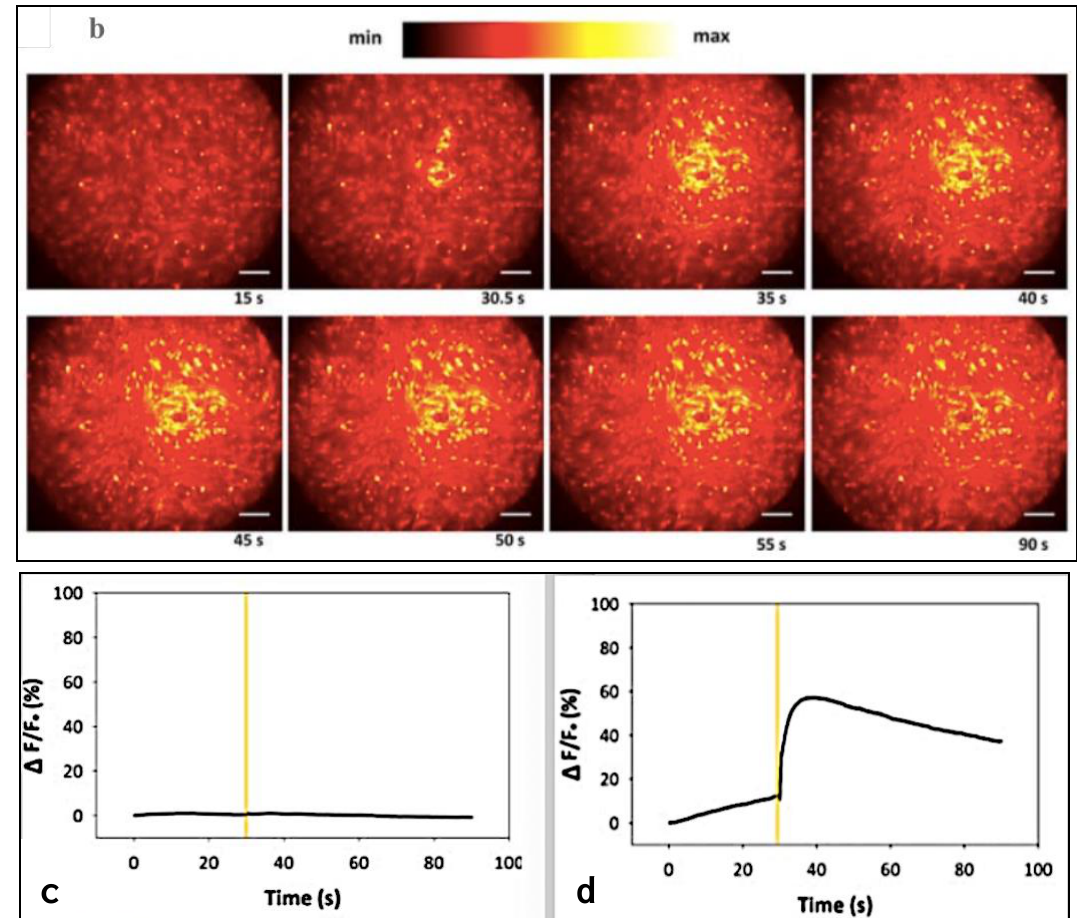
c d Figure 4. Characterization of near infrared (NIR) stimulation in the absence and presence of PNF. ( a ) Ca 2 + images at 15 s, 30.5 s, 35 s, 40 s, 45 s, 50 s, 55 s, and 90s without AuNR. ( b ) Ca 2 + images at 15 s, 30.5 s, 35 s, 40 s, 45 s, 50 s, 55 s, and 90 s with AuNR. ( c ) Intracellular Ca 2 + waves profile presented before and after optical pulse (yellow line) in the presence of a nonbinding AuNR system. ( d ) Intracellular Ca 2 + waves profile before and after optical pulse (yellow line) with a binding AuNR system. Reproduced with permission from [33]. John Wiley and Sons, 2017.